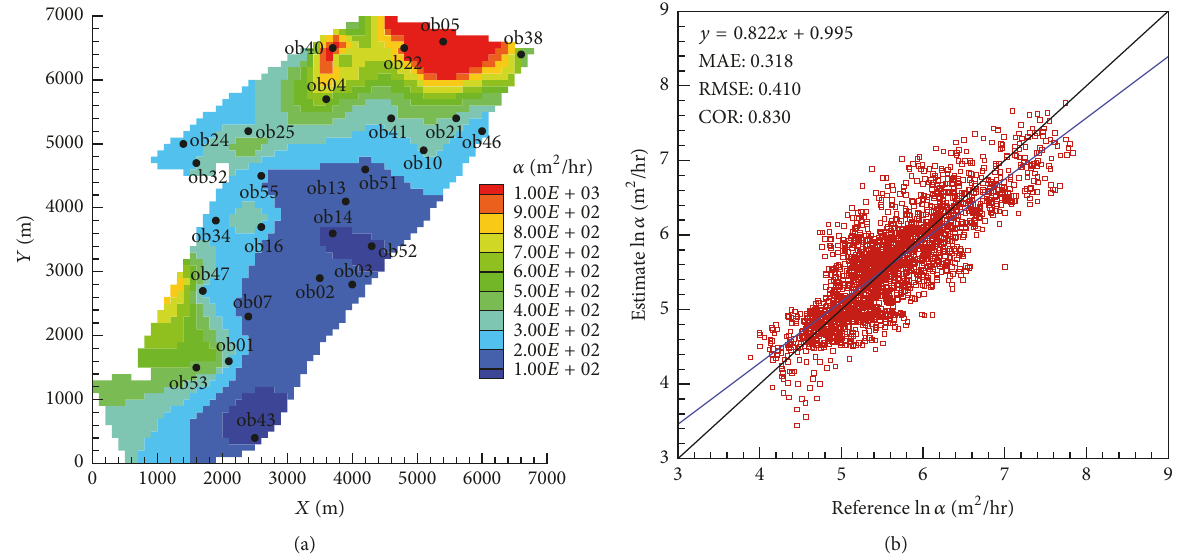
Figure 9: (a) Optimal estimated heterogeneous 𝛼 field in the synthetic aquifer (26th observation well used for the inverse model); (b) scatter plot of ln 𝛼 between the optimal estimated heterogeneous and reference 𝛼